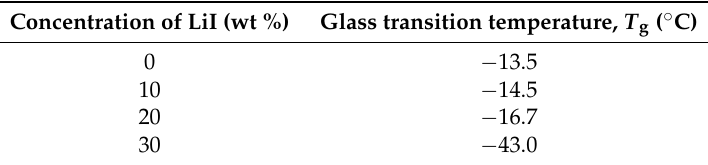
Figure 3. Tan δ versus temperature for CMKC/CMCE films with ( a ) 0; ( b ) 10; ( c ) 20 and ( d ) 30 wt % LiI. Table 2. Glass transition temperature for CMKC/CMCE-LiI films.